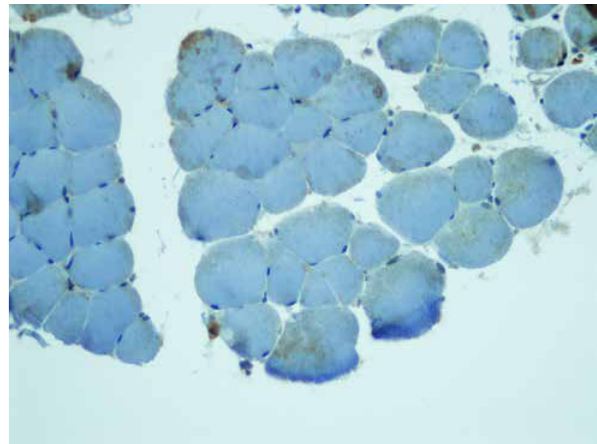
Figure 2. iNOS staing of sham group was very weak